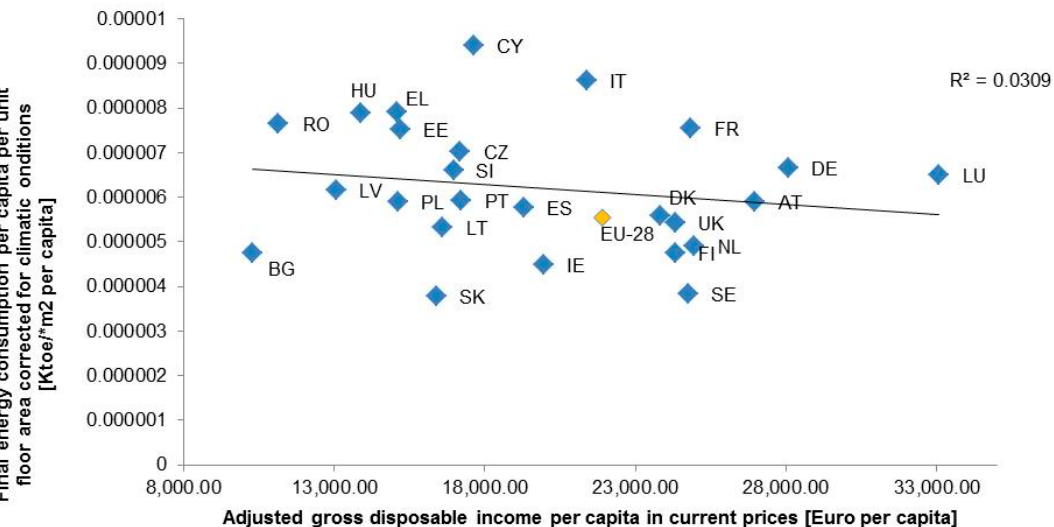
Figure 17. Correlation between residential energy normalized by climatic factor, average floor area, and population, and adjusted gross disposable income per capita for EU member states, 2015 Source: Eurostat, Odyssee.